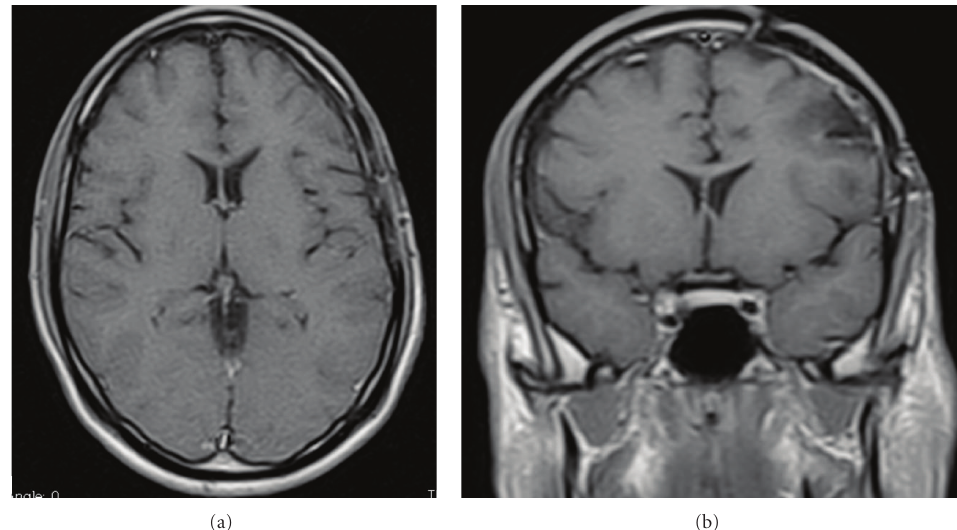
Figure 3: Postoperative MRI (after 4 years) in axial (a) and coronal (b) views, showing no residual tumor.